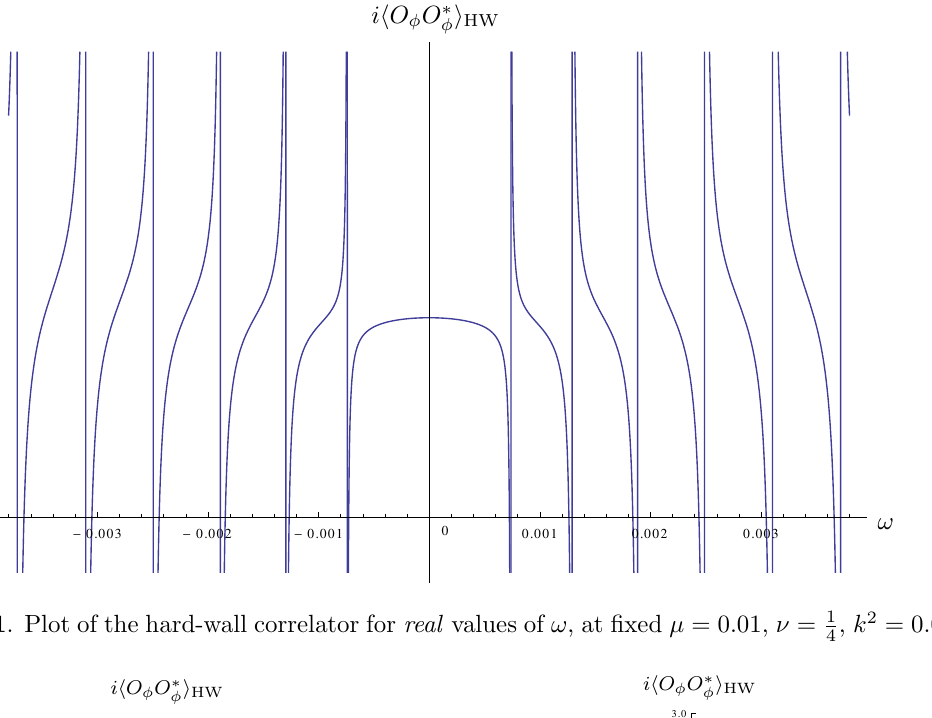
Figure 1 . Plot of the hard-wall correlator for real values of ! , at (cid:12)xed (cid:22) = 0 : 01, (cid:23) = 1